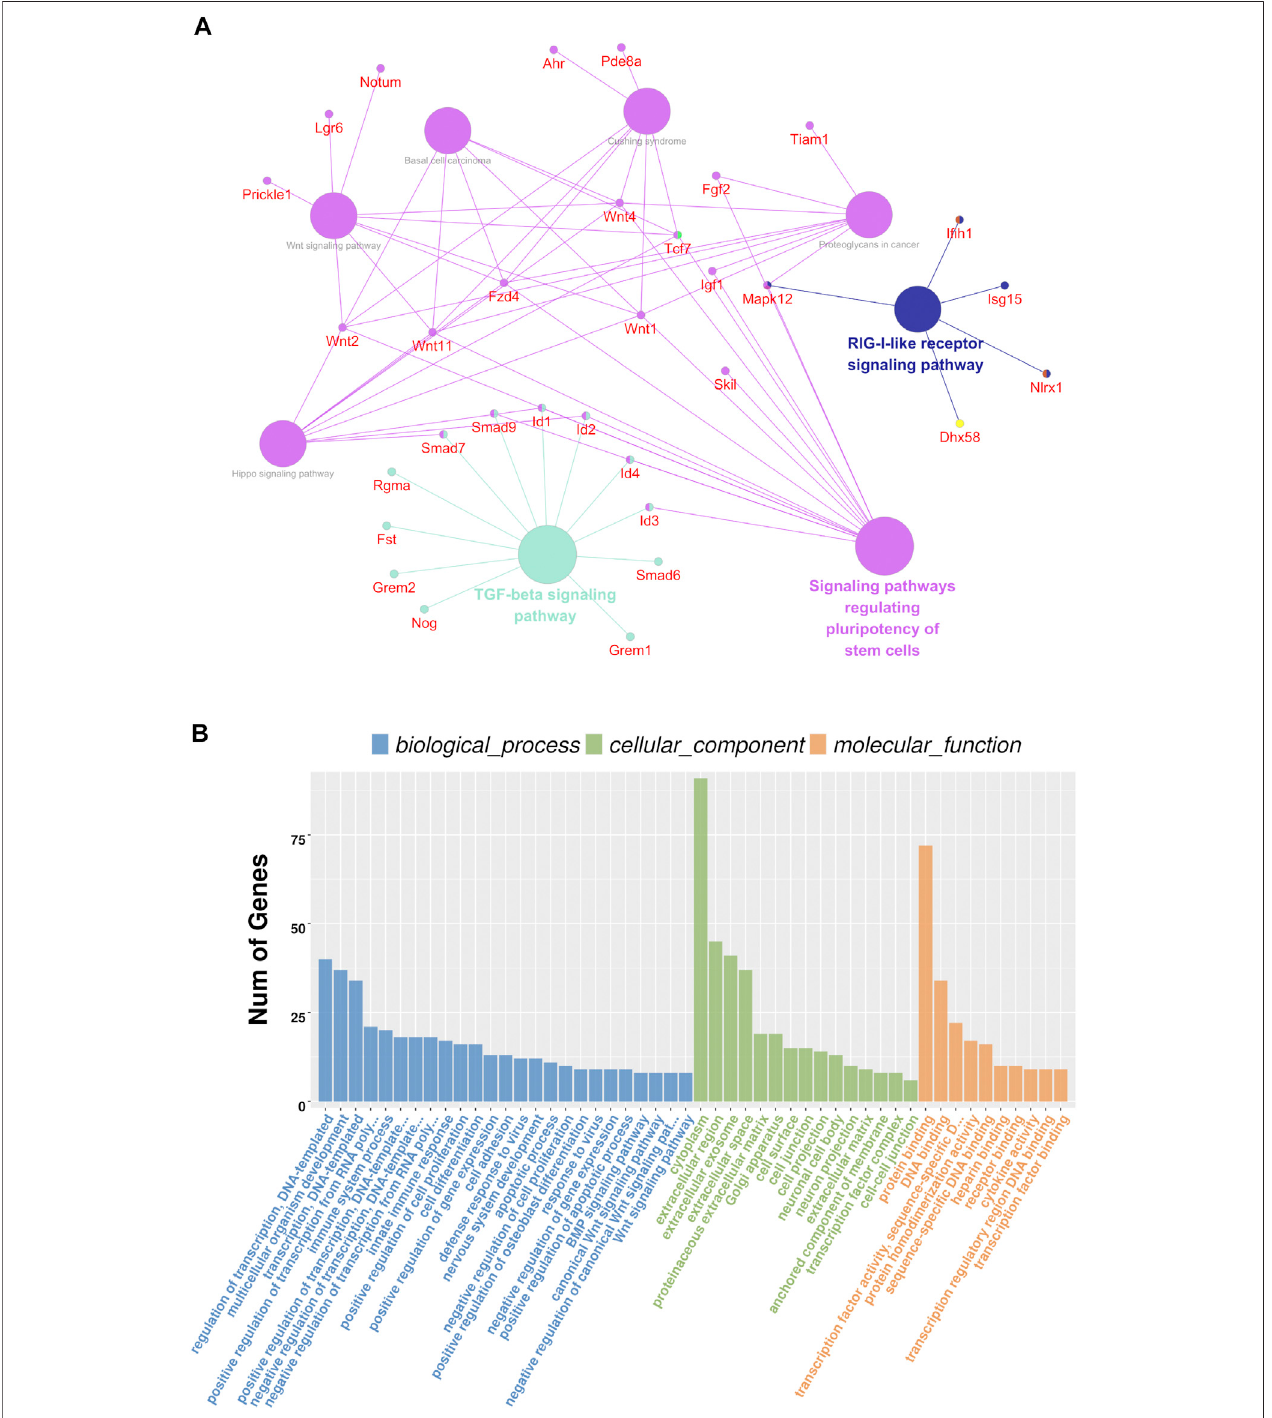
FIGURE4| AnalysisresultsofKEGG and GOanalyses. (A) Possible signaling pathways arerepresentedbycircles, and theinvolved genesarerepresentedbyred characters. The possible signaling pathways showed the larger diameters of the circle; the larger the diameters are the more signi fi cant the signal pathway is. (B) GO analysis in a cellular component, biological process, and molecular function.